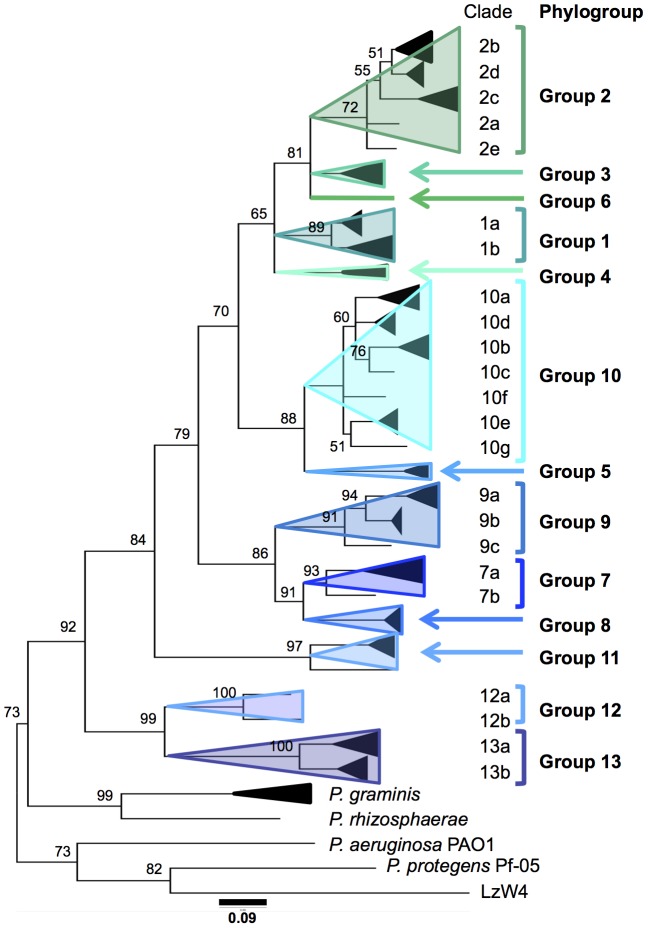
Bayesian tree constructed on the concatenated sequences cts, gyrB, gapA and rpoD of 216 P. syringae strains.Bootstrap values are showed at each node. Strain taxa were compressed and clade and phylogroup names are indicated (see the expanded tree with strain names in Fig. S1). Phylogroups from 1 to 7 were already reported in Parkinson et al. [4], phylogroup 8 in [30], phylogroups 9, 10, and 13 were described with other names by Morris and coworkers [2] (see Table S8 for name correspondence), phylogroup 11 corresponds to P. cichorii strains and phylogroup 12 was not described previously. The tree was rooted on P. aeruginosa PAO1.